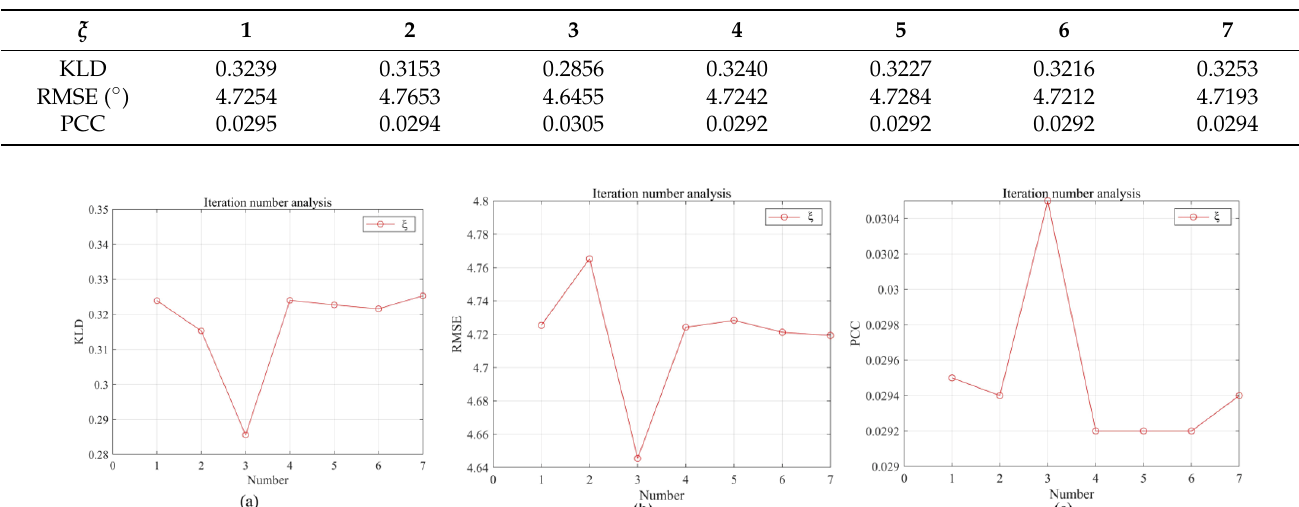
Figure 10. Wind direction sequence obtained by FC-GLCM algorithm when parameter σ is differ- ent. (The pink curve with the open points represents the wind direction measured by the vane anemometer.) Table 4. Sensitivity analysis of iteration number ξ .